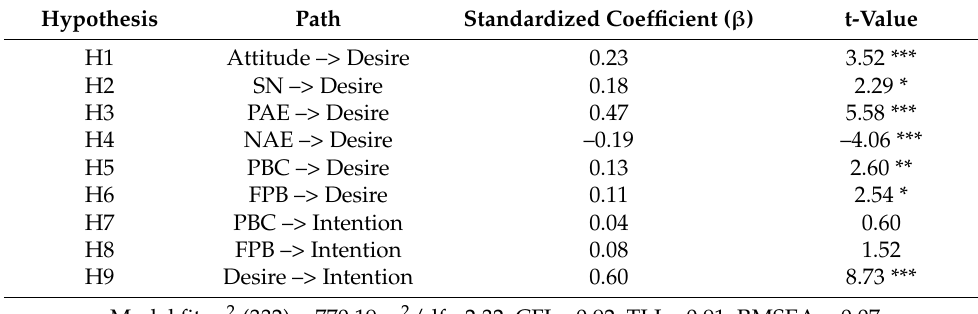
Table 3. Summary of hypothesis testing results.